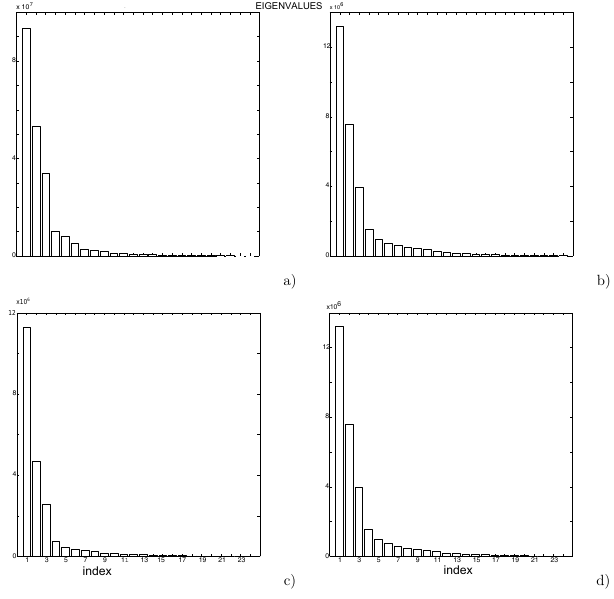
Fig. 7. PCA results: Eigenvalues relative to the signals of the four stations composing the seismic network (from De Lauro et al., 2009a): (a) E1S; (b) NKB; (c) CON; (d) LEH. The first three eigen- values retain the 84%, 80%, 86%, and 75% of information at each respective